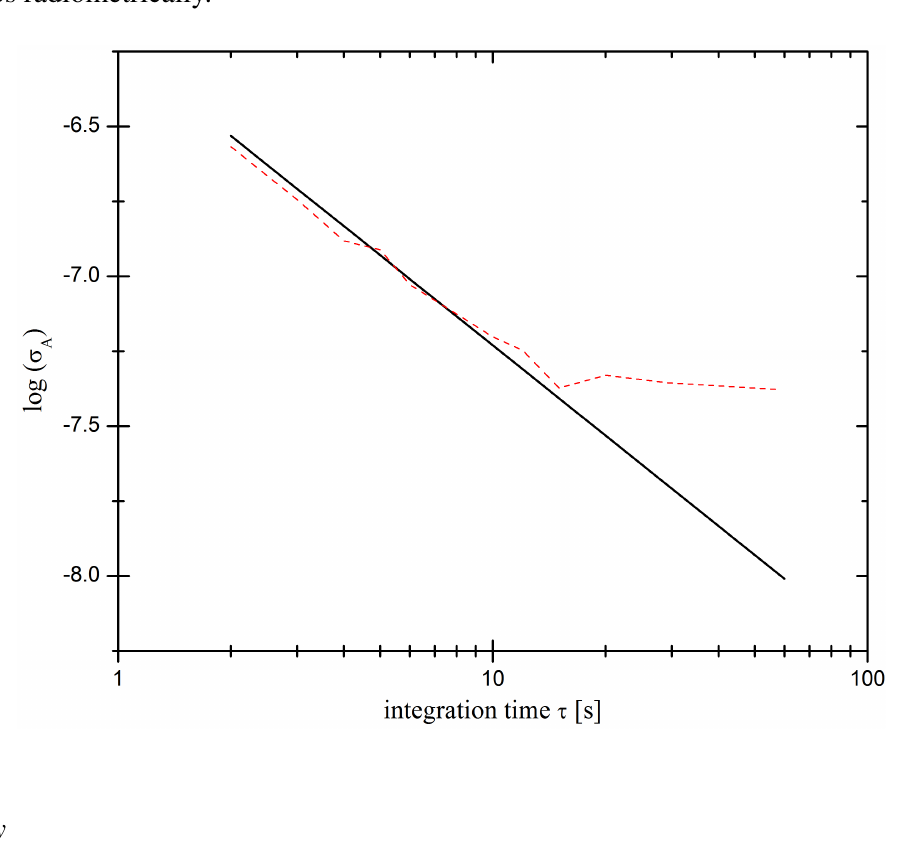
The variance of the noise amplitude is plotted vs . the integration time on a double logarithmic scale. The black line represents the theoretical decrease for pure white noise. The red line represents the measurement. The minimum of the variance can be found at an integration time, ≈ 10 s. Within this time interval, the noise amplitude decreases